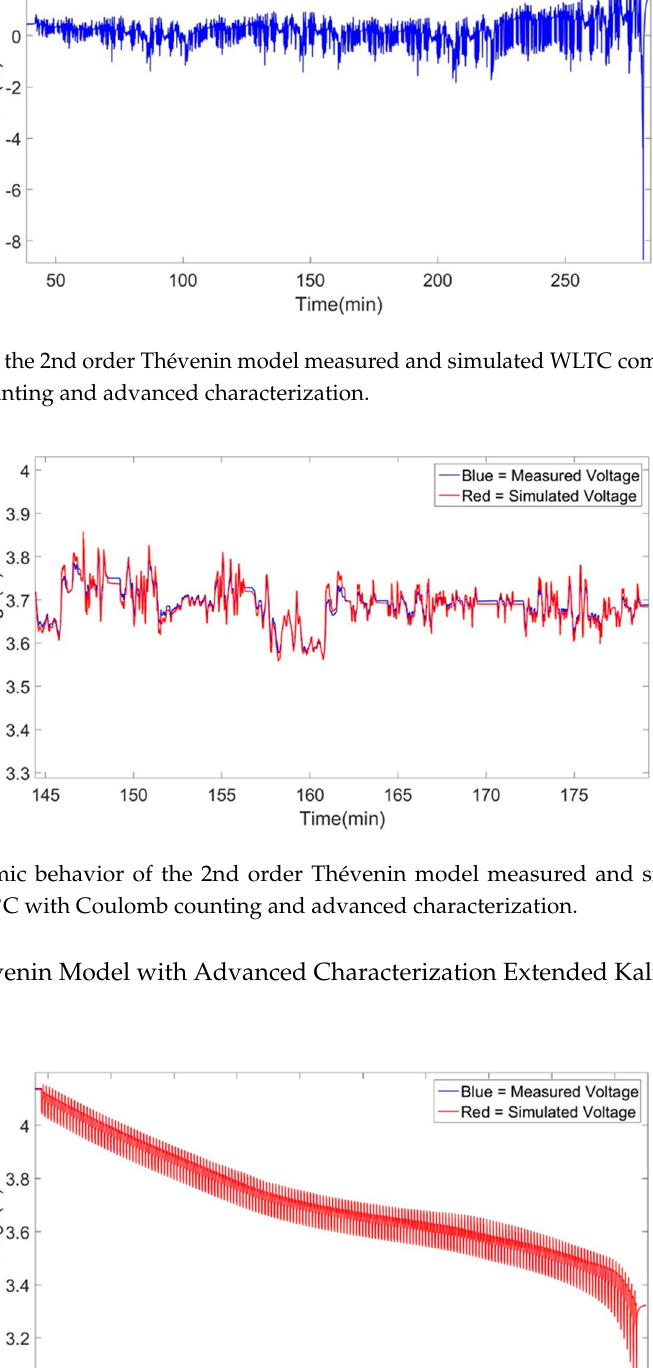
Figure 19. 2nd order Thévenin model measured and simulated worldwide harmonized light vehicle test procedure (WLTC) comparison at 25 °C with Coulomb counting and advanced characterization.